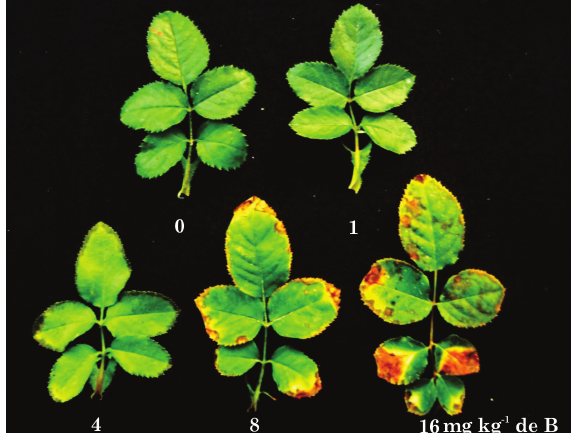
Figura 3. Sintomas de toxidez causados por B em folhas maduras de roseira (cv. Shiny Terrazza ® ), a partir da dose de 4 mg kg -1 desse